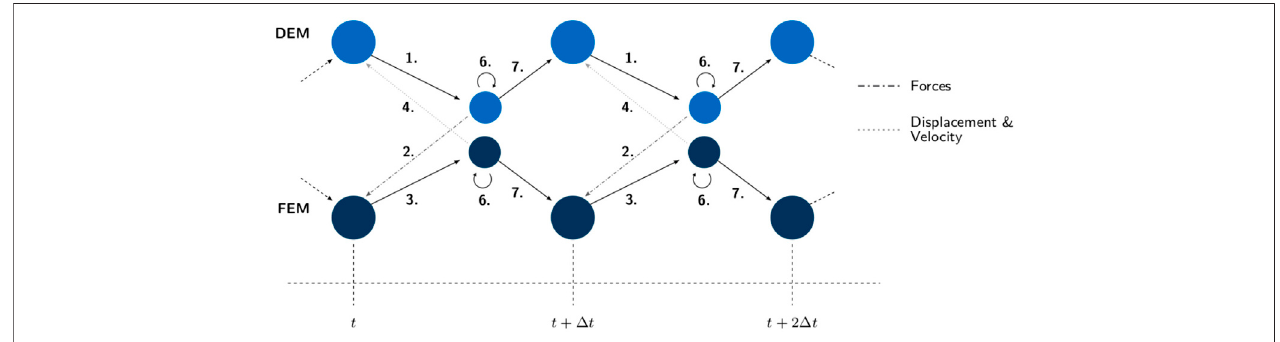
FIGURE 5 | Strong coupling communication diagram from Sautter et al. (2020). With t as the current time and Δ t as the time step size.